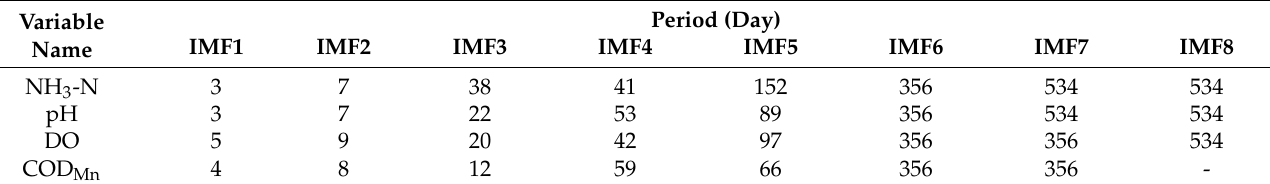
Table 2. The period of IMF components for water quality parameters.